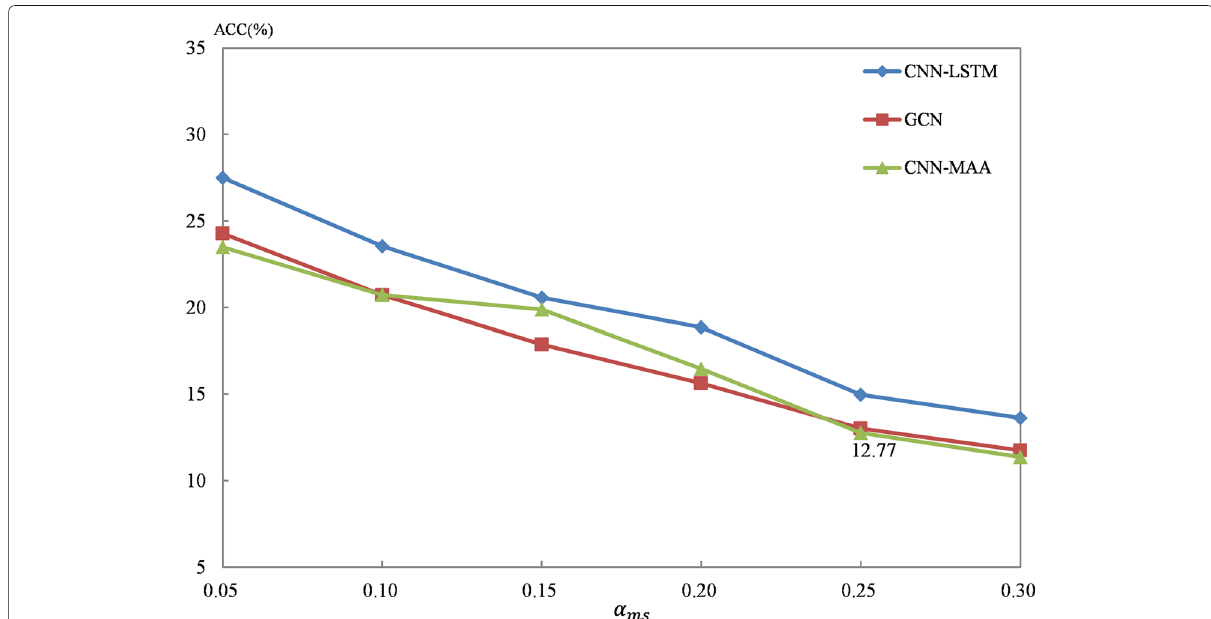
Fig. 8 Description of the three models under the modulation spectrum smoothing